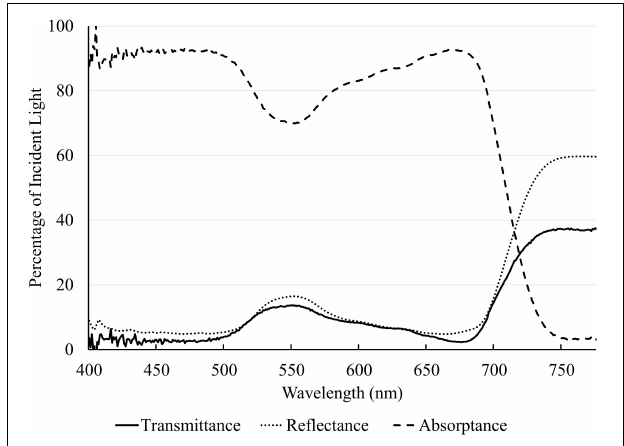
FIGURE 2 | Light absorptance, reflectance, and transmittance spectrum of a newly fully expanded “Green Towers” lettuce leaf.